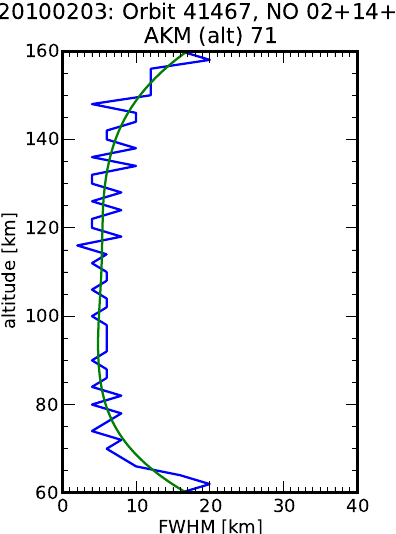
Fig. 7. FWHM of the altitude averaging kernel matrix elements for a sample orbit (no. 41467, 3 February 2010) as an indicator of vertical resolution.